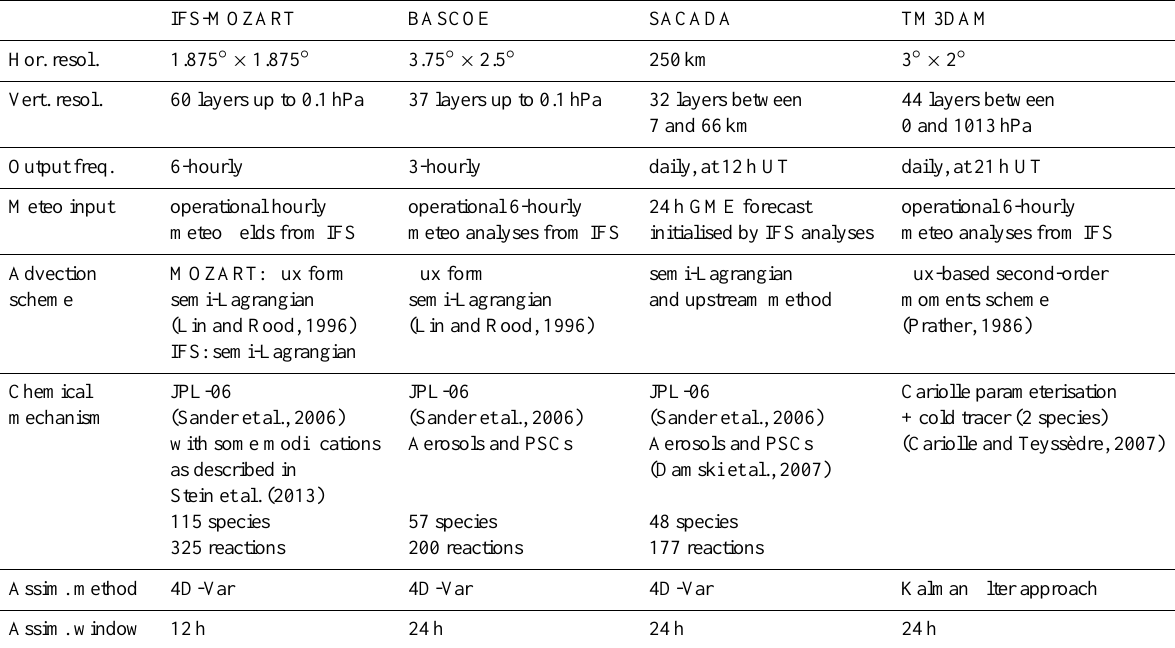
Table 2. Specification of the characteristics of the four assimilation systems: IFS-MOZART; BASCOE; SACADA; and TM3DAM. The horizontal and vertical resolution have been abbreviated to Hor. and Vert. resol. respectively. Freq. stands for frequency, and Assim. for assimilation.